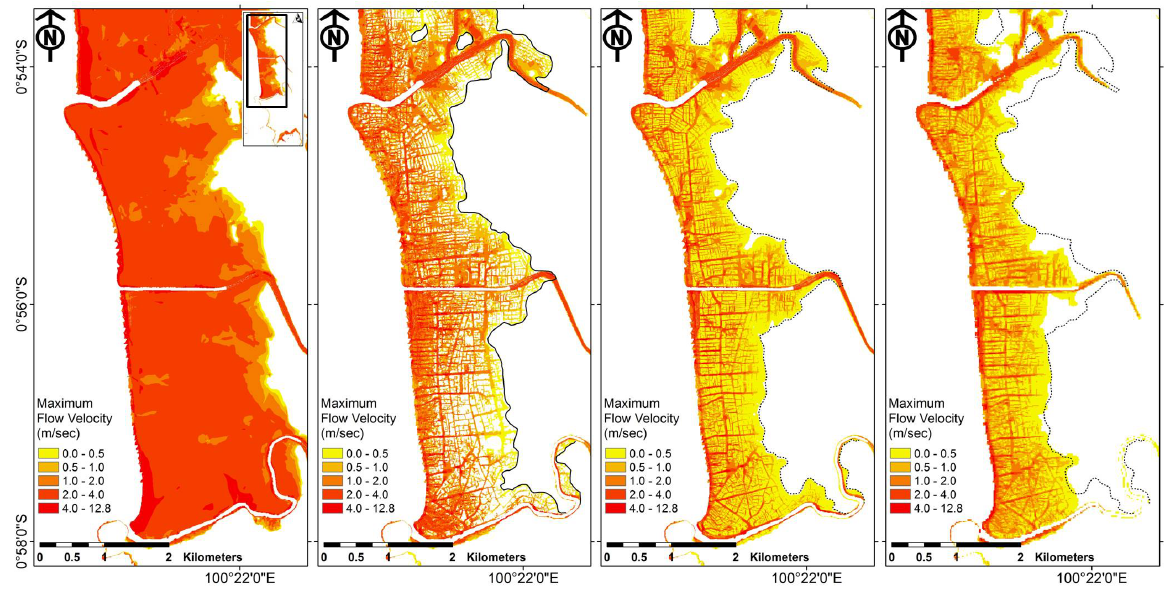
Fig. 16. The distribution of maximum velocity. From left to the right hand side: CRM, TM, ERM (5m), and ERM (15m)